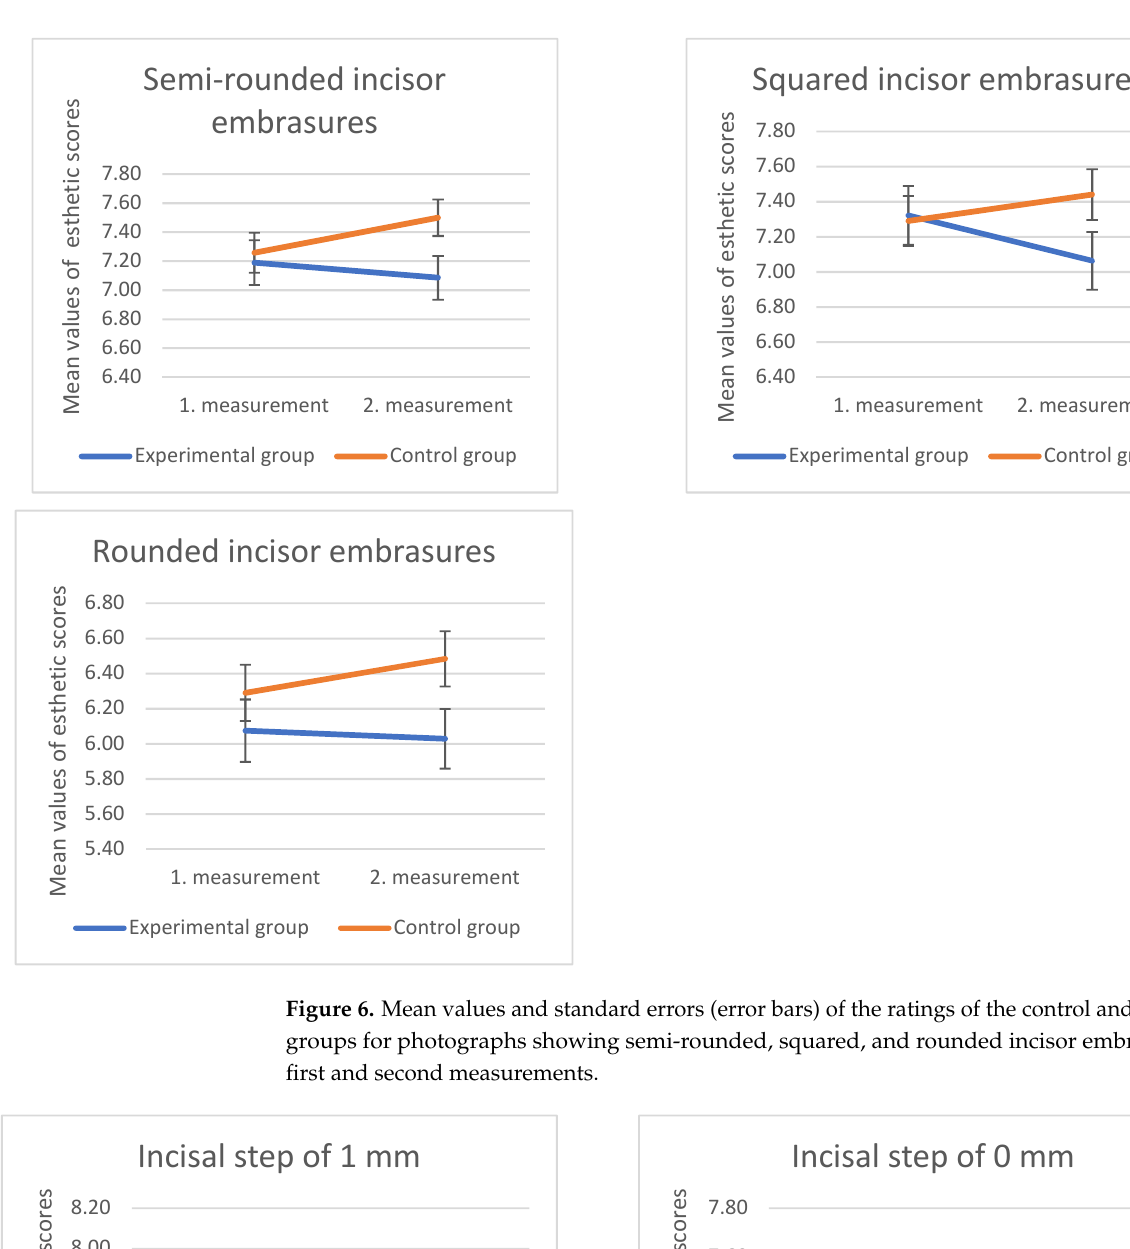
Figure 8. Mean values and standard errors (error bars) of the ratings of the control and experimental groups for images showing a midline diastema of 1 and 3 mm, in the first and second measurements . Self-perception of smile did not differ significantly between control and experimental groups after exposure to social media (Figure 9). In those exposed to Instagram (experi- mental group), laypeople showed significantly greater satisfaction with their own smile after the exposure to Instagram, whereas no such difference was present in the control group (mean values of the scores of the “laypeople” experimental group pre-exposure = 7.63 ± 1.87, post-exposure = 7.62 ± 1.77) ( p = 0.03).